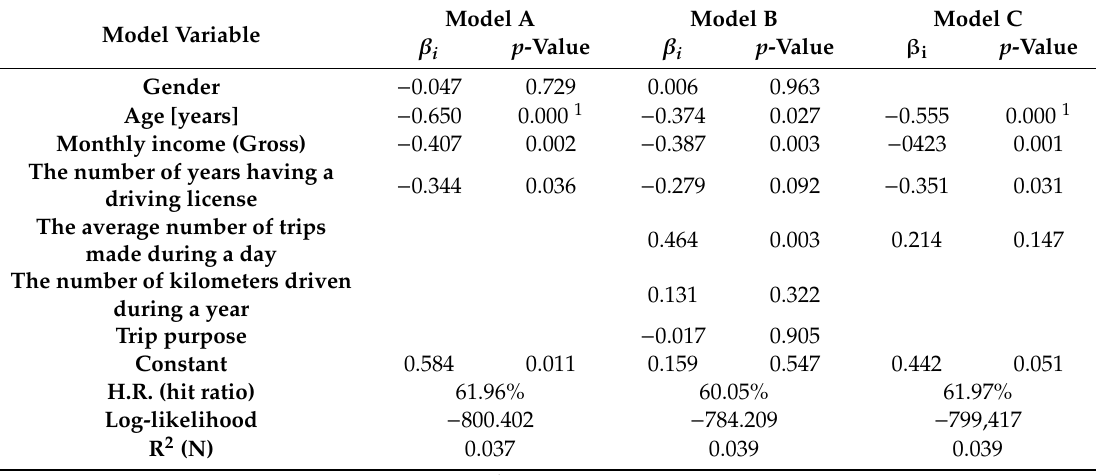
Table 5. Logit model